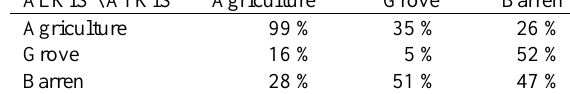
Table 6. Properties for corresponding land-use classes (row: ATKIS, column: ALKIS)